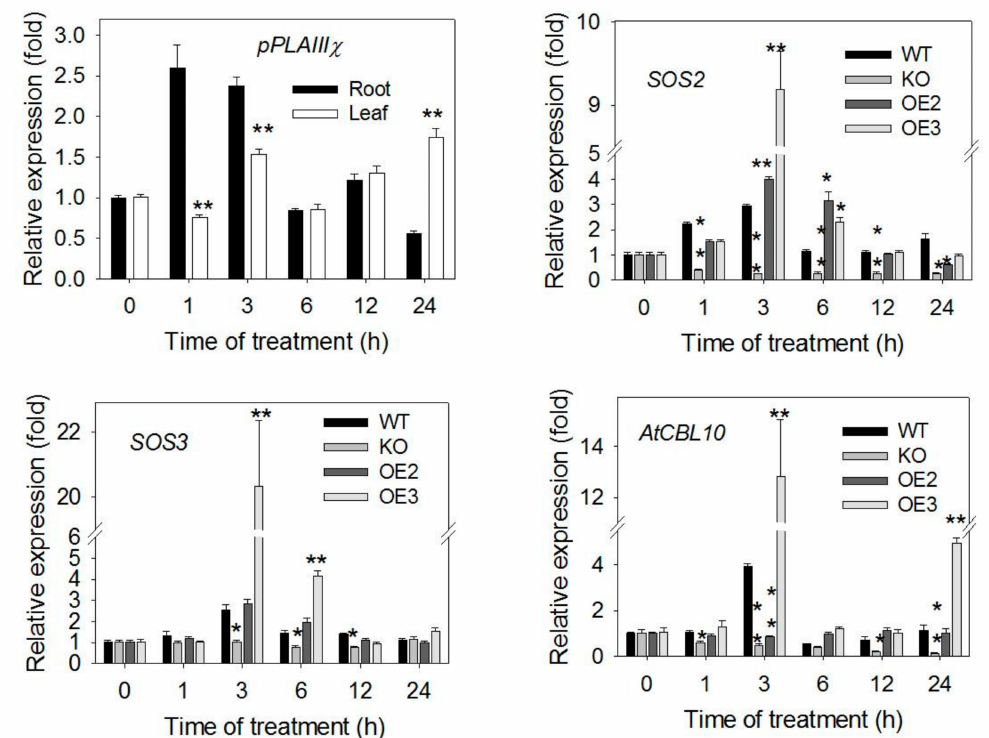
Figure 7. Transcript levels of pPLAIII γ and SOS genes in WT, KO and OE lines under 0 and 100-mM NaCl. Transcript level of pPLAIII γ measured by qPCR in leaves and roots of WT with and without 100-mM NaCl at di ff erent time points (1–24 h). Transcript levels of SOS2 , SOS3 , AtCBL10 quantified by qPCR in roots of WT and KO seedlings with treatments as above. UBQ10 was used as internal control and data represent means ± SE ( n = 4 technical repeats). asterisk presents a significant di ff erence at 0.05 level by Students’